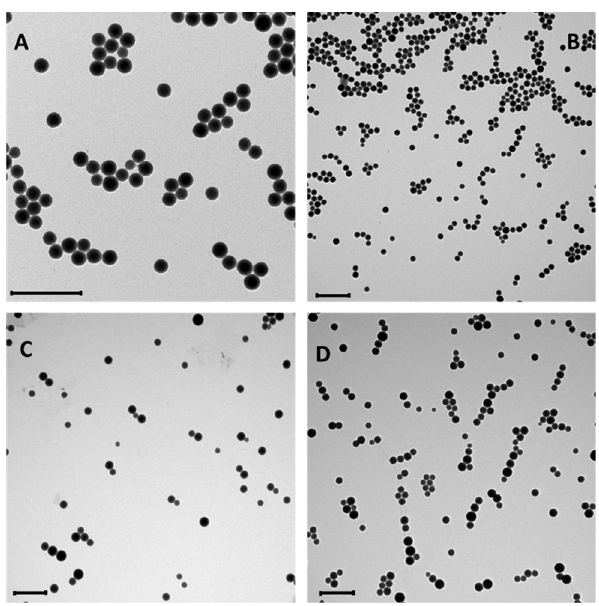
Figure 5. Representative TEM images of: NPs ( A ), NH 2 -NPs ( B ), Ab-CD44v6-NPs ( C ), HA-NPs ( D ). Scale bars: 500 nm.